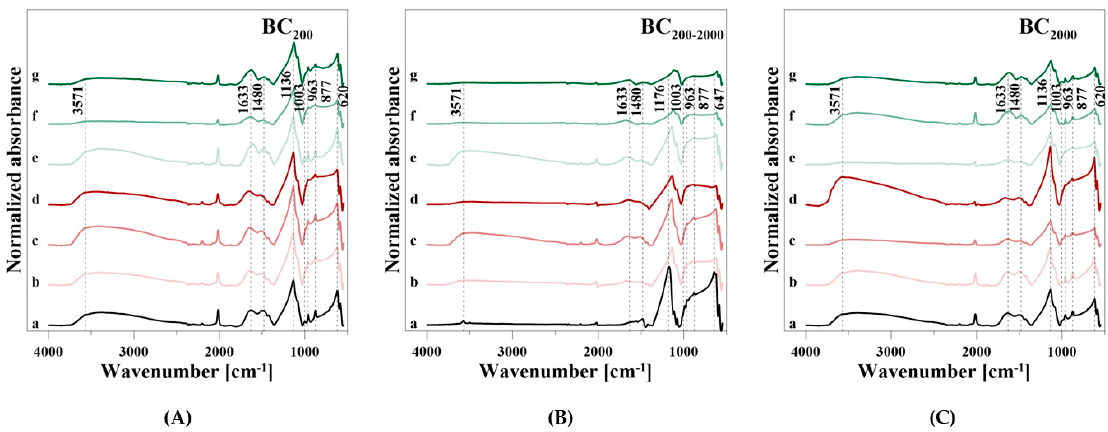
Figure 8. FT-IR spectra of bone char divided into ( A ) BC 200 , ( B ) BC 200–2000 , and ( C ) BC 2000 during P release. (a) reference (b) 0.01 M CaCl 2 , (c) 0.05 M CaCl 2 , (d) 0.1 M CaCl 2 , (e) 0.01 M CA, (f) 0.05 M CA, and (g) 0.1 M CA.